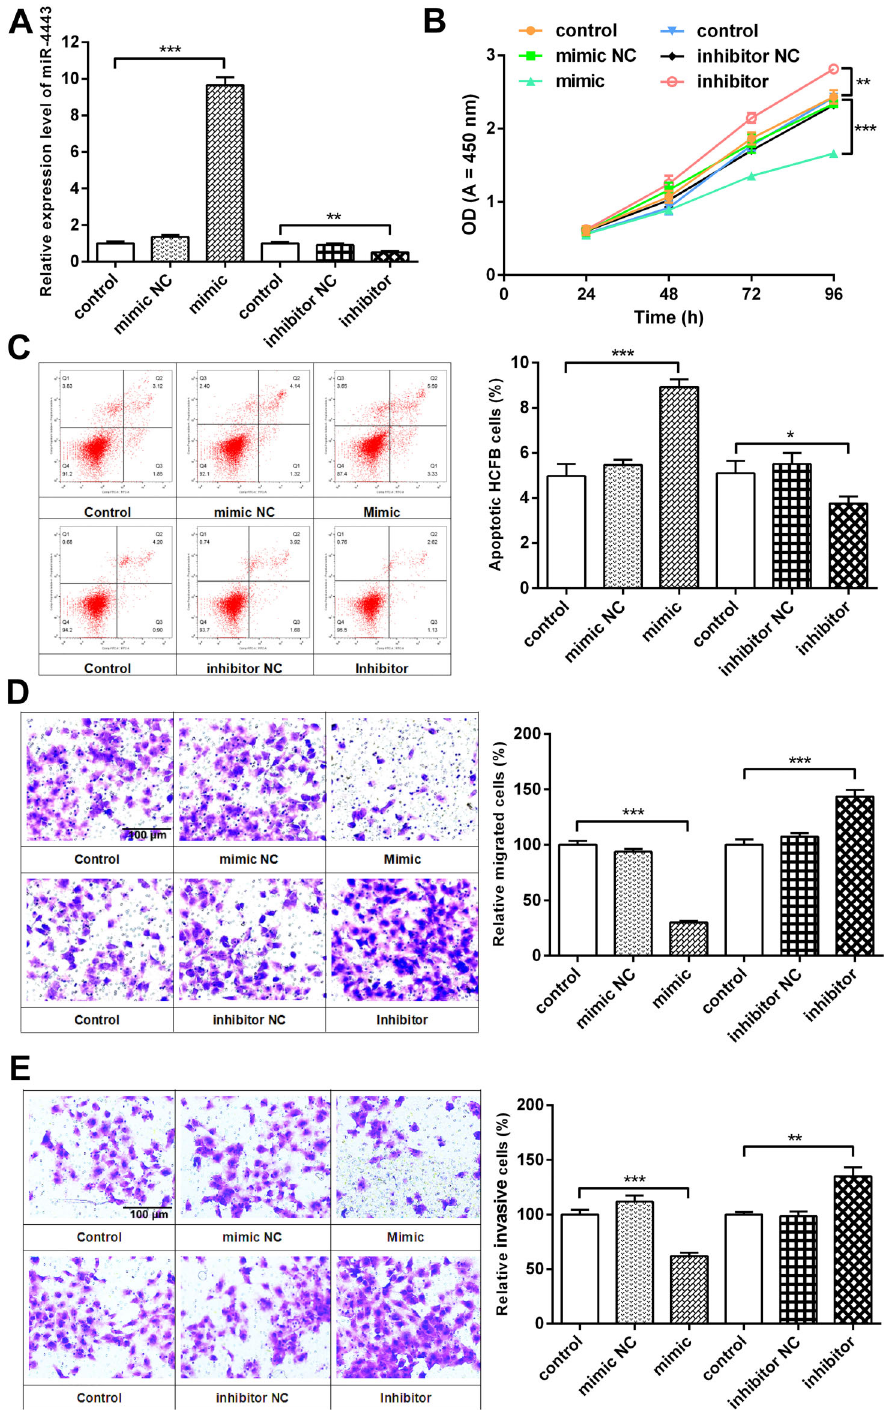
Figure 2. hsa-miR-4443 affected the biological function of human cardiac fi broblast (HCFBs). A , HCFBs were transfected with hsa-miR- 4443 mimic or inhibitor. hsa-miR-4443 expression affected cell proliferation ( B ), apoptosis ( C ), migration ( D ), and invasion ( E ) (scale bars, 100 m m). All data are reported as means ± SD of at least three independent experiments. *P o 0.05, **P o 0.01, and ***P o 0.001 vs control (one-way ANOVA analysis with two-sided LSD post hoc test). NC: negative